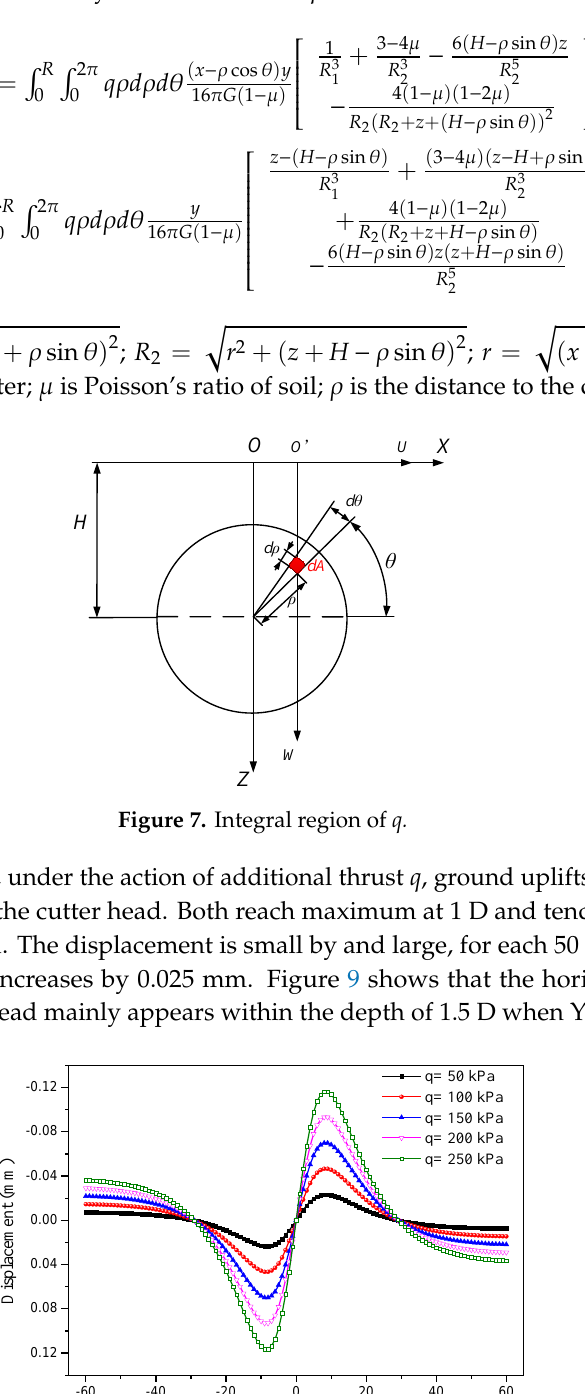
Figure 9. Horizontal displacement of stratum caused by q . 4.3. Quantitative Analysis of Frictional Force f d Based on the integral region shown in Figure 7, frictional force f d between the shield working face and the soil is expressed as Equation (12), which can be decomposed into horizontal load f dH and vertical load f dV , as Equation (13). The solution of total stratum displacement can be obtained by compositing the displacements of Equation (10).